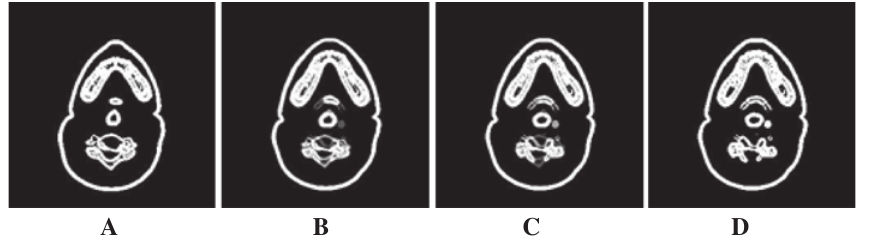
Figure 5: Re-creation of slices using REG based interpolation. (B and C) are re-created slices by applying REG based interpola- tion to the selected segmented slices (A and